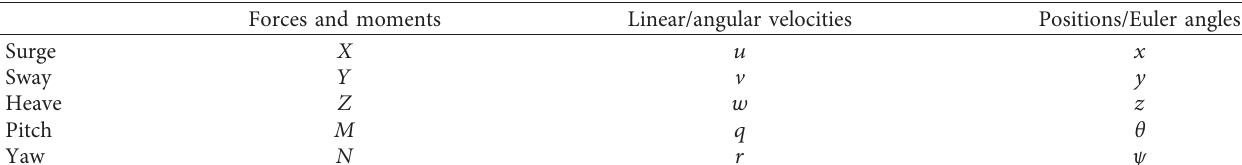
Table 1: The symbols for an UUV.